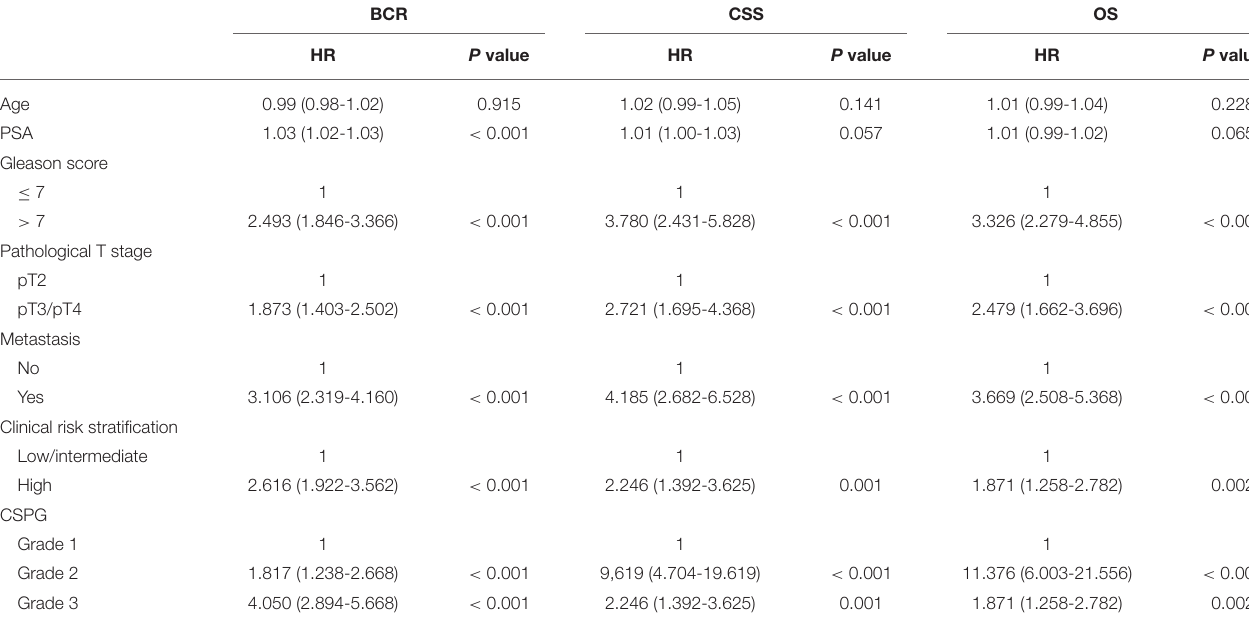
TABLE 3 | Results of univariate Cox analysis.